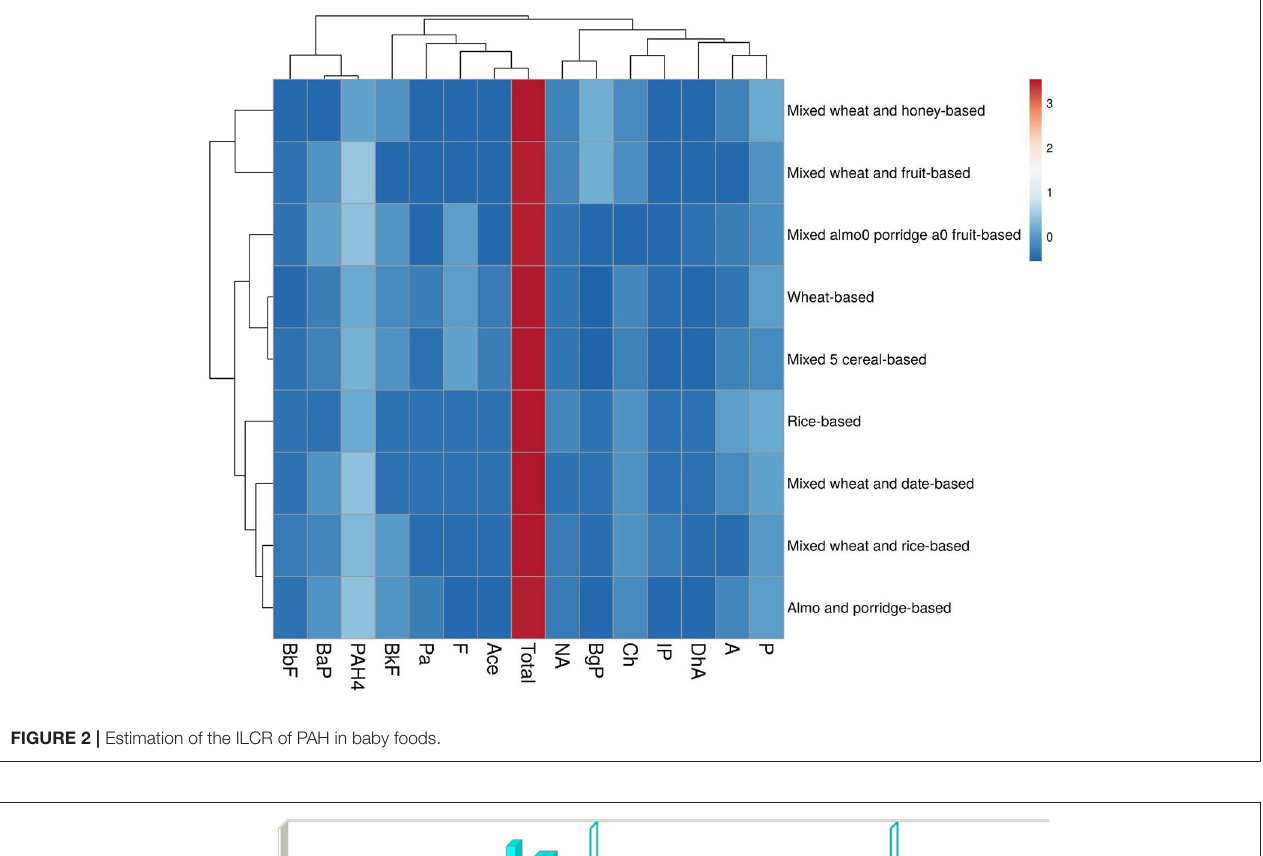
FIGURE 2 | Estimation of the ILCR of PAH in baby foods.